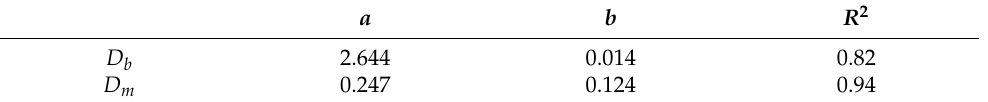
Figure 11. Fractal dimension under various freezing durations: ( a ) fractal dimension for bound fluid; ( b ) fractal dimension for movable fluid. Table 3. Summaries of model parameters for fractal dimension under various freezing durations.